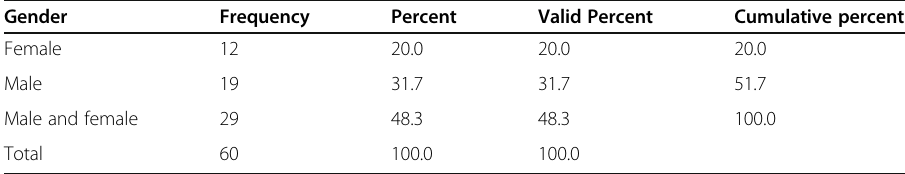
Table 5 Frequency distribution of researches by gender